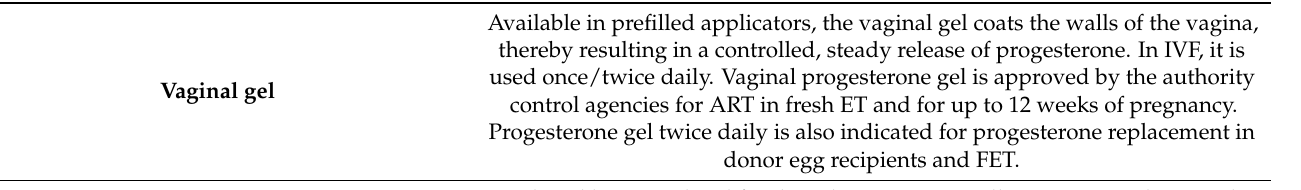
Table 2. Vaginal progesterone preparations available for